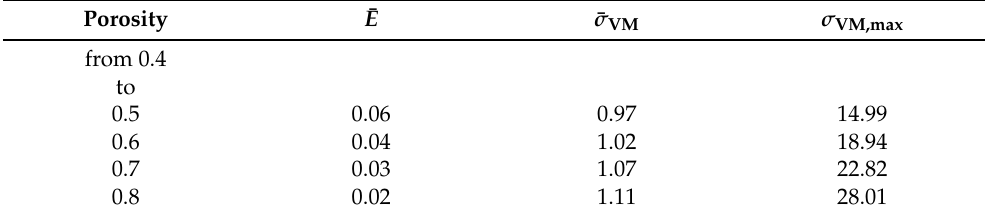
Table 5. Scaled results of the gyroid structure with a linear gradient [dimensionless] of the normalised effective Young modules ¯ E , a mean von Mises stress ¯ σ VM , and a maximum von Mises stress σ VM,max , which is given for different porosities.